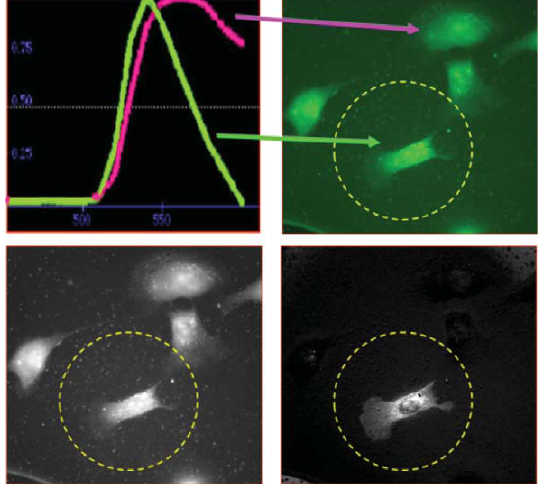
Fig. 2. Removal of autofluorescence reveals an otherwise unde- tectable YFP+ transfected cell.